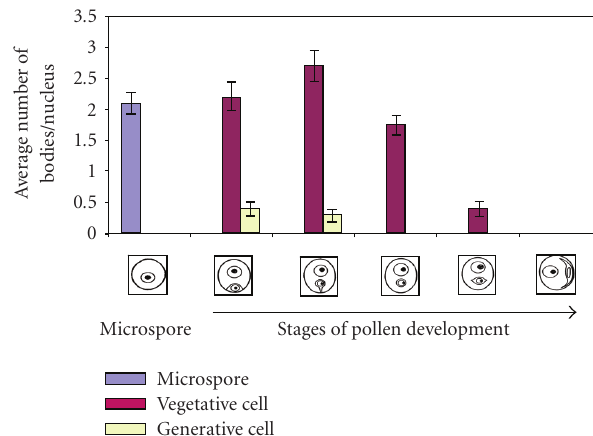
Figure 2: Graph illustrating the average number of silver nitrate- stained extranucleolar bodies in the polarized microspores and di ff erentiating pollen cells. In the microspore the average number of nuclear bodies was 2.2. During the whole course of pollen development the number of these structures was much higher in the vegetative nucleus that in the generative one. Until the separation of the generative cell from the sporoderm, the average number of agyrophylic nuclear bodies in the vegetative nucleus was the highest and reached values of over 2 per nucleus. During later stages of pollen development the average number of nuclear bodies in the vegetative nucleus successively decreased. In the generative nucleus silver nitrate-stained bodies were observed only in young pollen grains and their average number never reached over 0.5 per nucleus. In both nuclei of mature pollen grain no nuclear bodies were indicated. The values represent the average of three replicate experiments; the error bars indicate one standard error of the